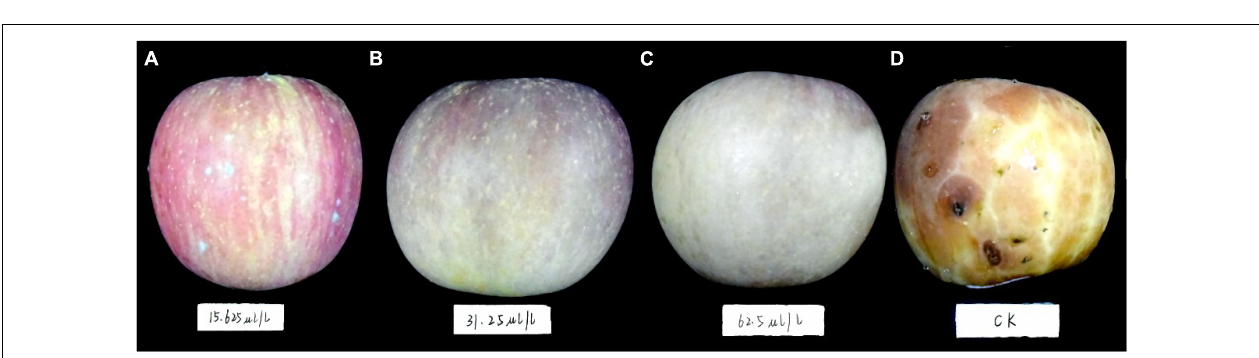
FIGURE 5 | The inhibitory effect of dimethyl trisulfide on the apple ring rot on apple fruit. (A) The disease spot diameter on apple fruits treated by various concentrations of dimethyl trisulfide. (B) The inhibition of various concentrations of dimethyl trisulfide against the apple ring rot on fruit. (C) The area-under-curve (AUC) of disease spot diameter on fruit treated by the various concentration of dimethyl trisulfide. Different lowercase letters indicate a significant difference between different treatments ( P < 0.05).